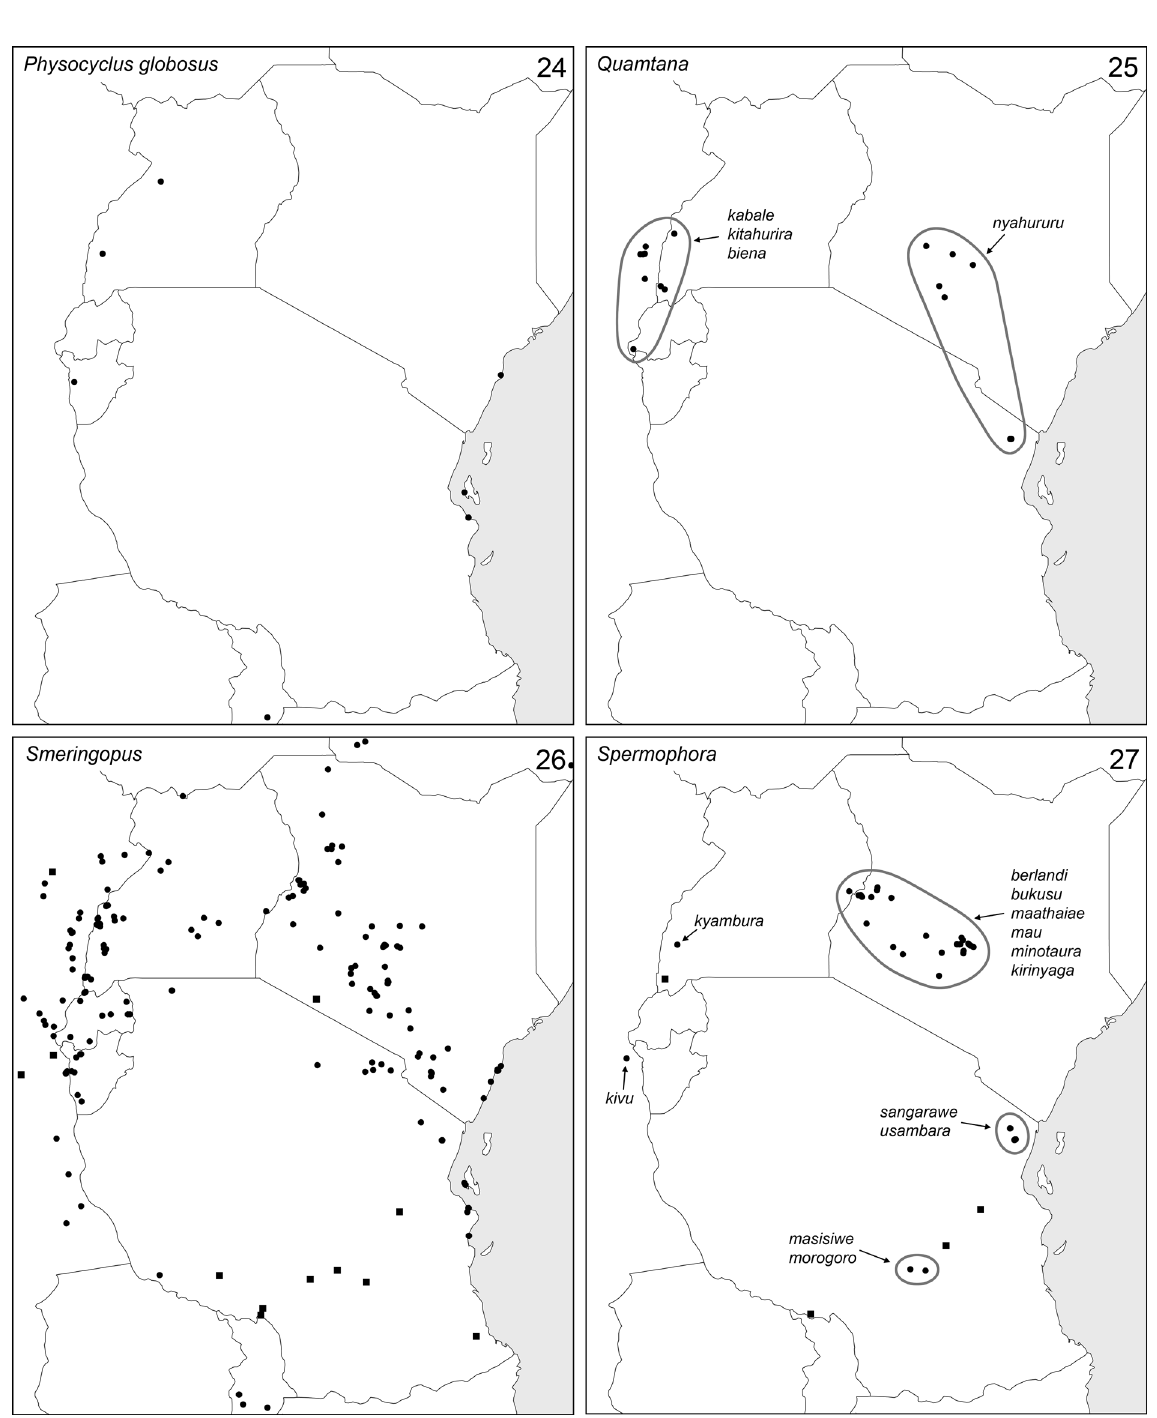
Figs 24-27. Known distributions of the genera Physocyclus , Quamtana , Smeringopus and Spermophora in east Africa. For detailed maps of Quamtana see Huber (2003b), of Smeringopus see Huber (2012) and of Spermophora see Huber (2003a). Squares: unidentified/undescribed